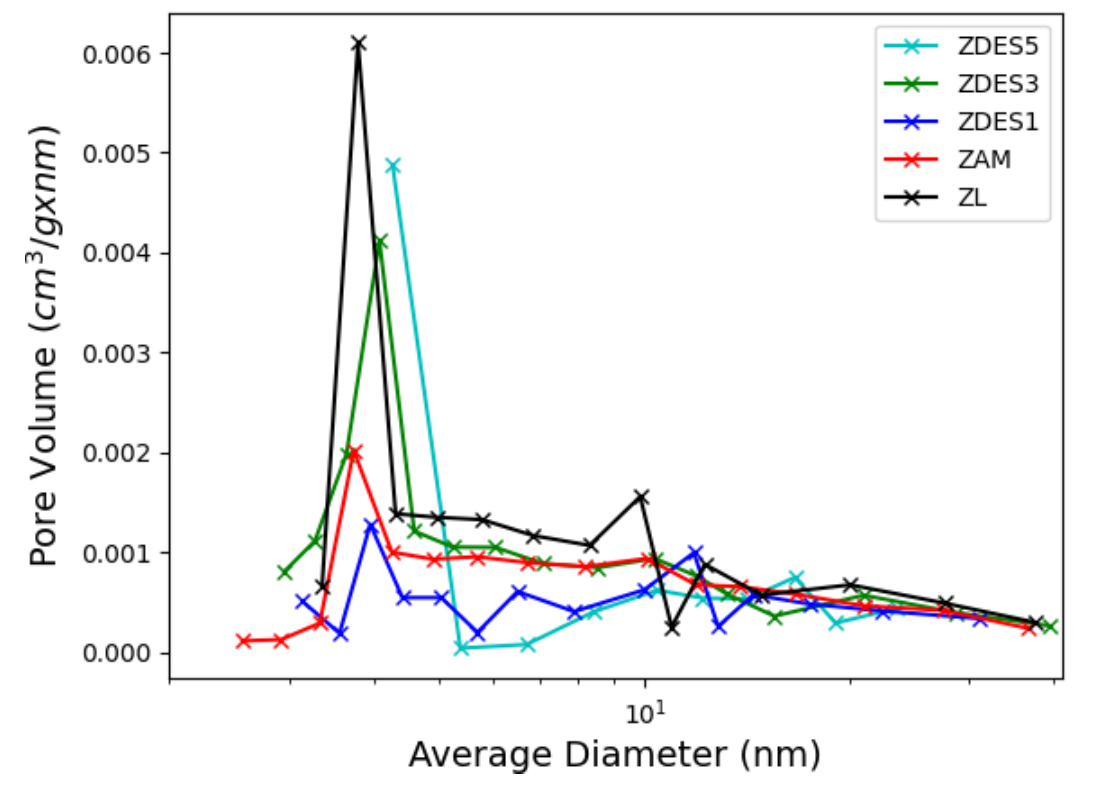
Figure 8. Pore diameter distribution of samples.